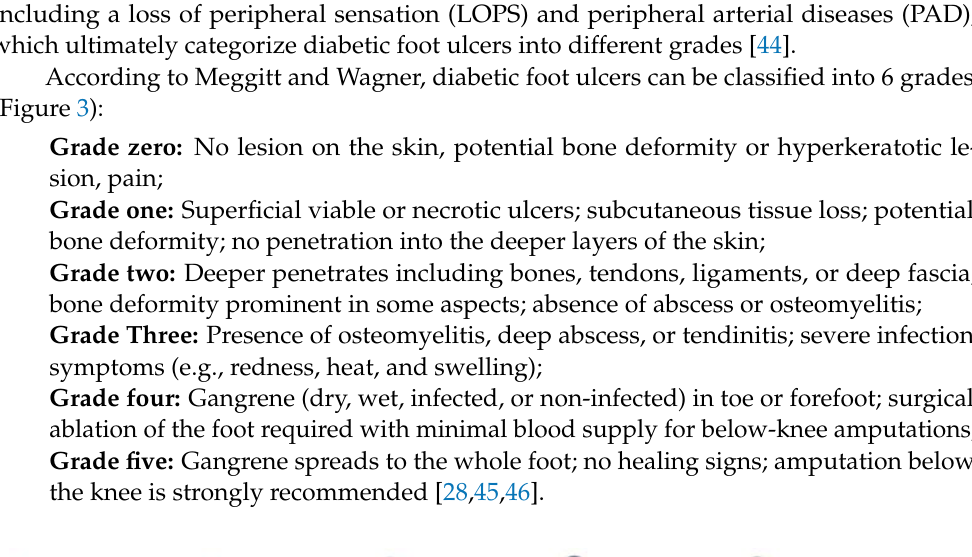
Grade zero: No lesion on the skin, potential bone deformity or hyperkeratotic le- sion, pain; Grade one: Superficial viable or necrotic ulcers; subcutaneous tissue loss; potential